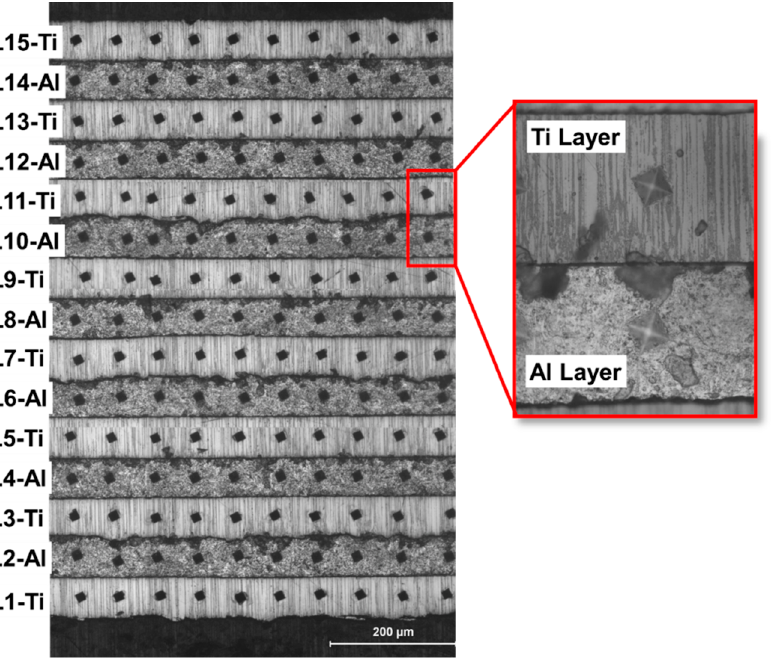
Figure 12. Micro-indentations on different layers of bulged sample at RT at 0.0013/s strain rate of Ti-Al laminated composite.